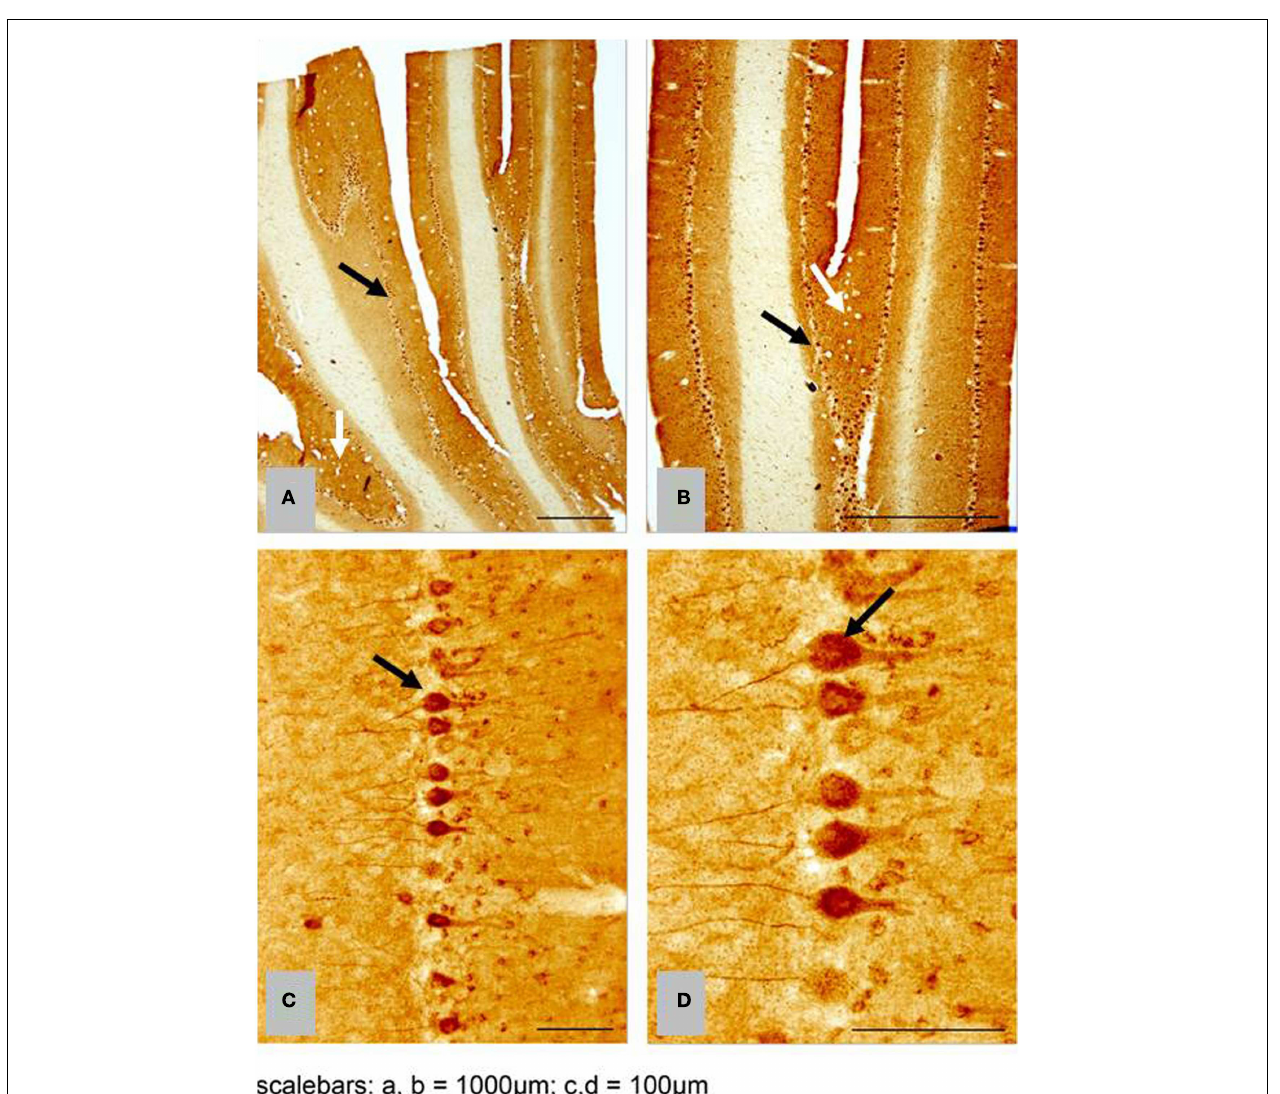
marked immunostaining of Purkinje cells (black arrows), but also exhibiting diffuse staining of the granular and molecular layer (white arrows). (C,D) High magnification view of Purkinje cells in (A,B) showing intracellular accumulation of A β positive material. CCD, canine cognitive